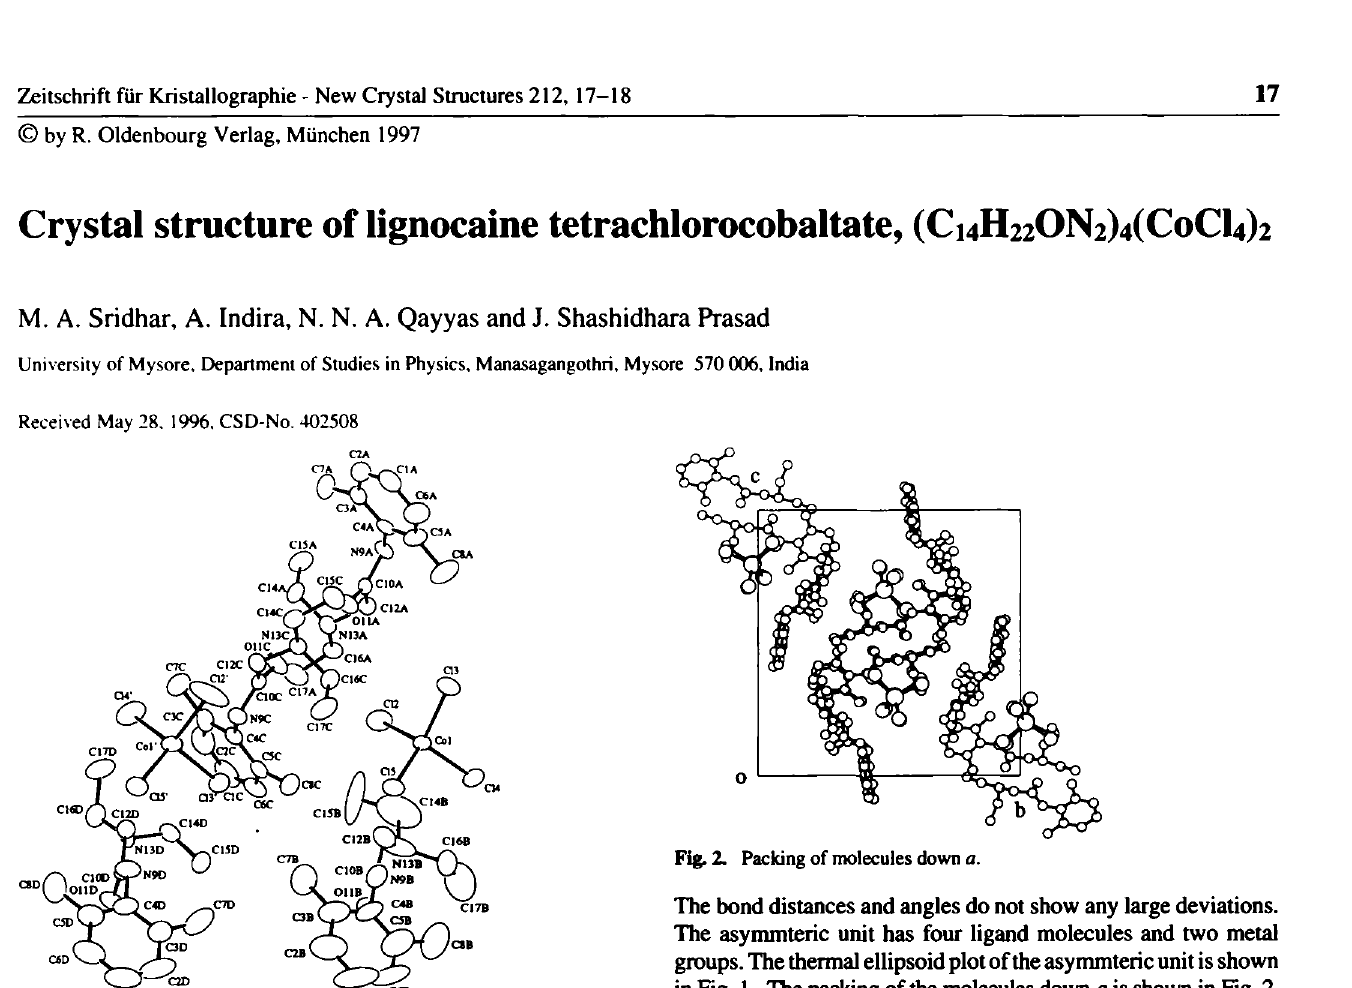
The bond distances and angles do not show any large deviations. The asymmteric unit has four ligand molecules and two metal groups. The thermal ellipsoid plot of the asymmteric unit is shown in Fig. 1. The packing of the molecules down a is shown in Fig. 2. The molecules are stacked and the metal and ligands do not form independent layers. C56H88CI8C02N8O4, monoclinic, P12i/nl (No.